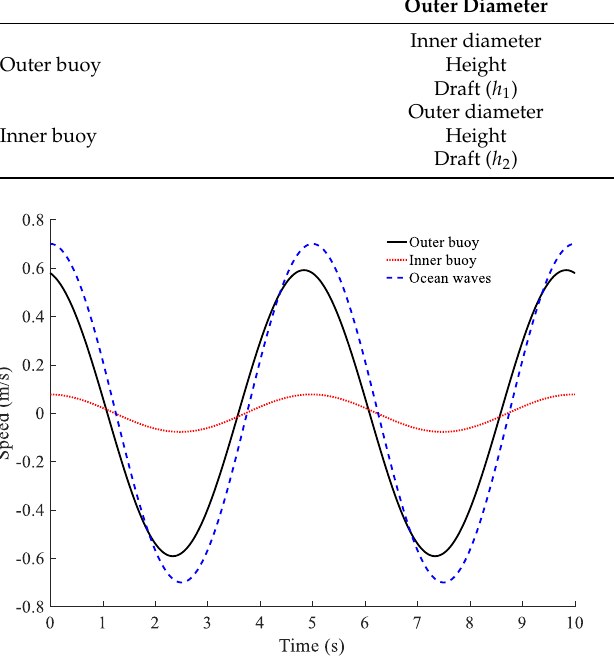
Figure 3. The vertical direction speed of the outer buoy and inner buoy.